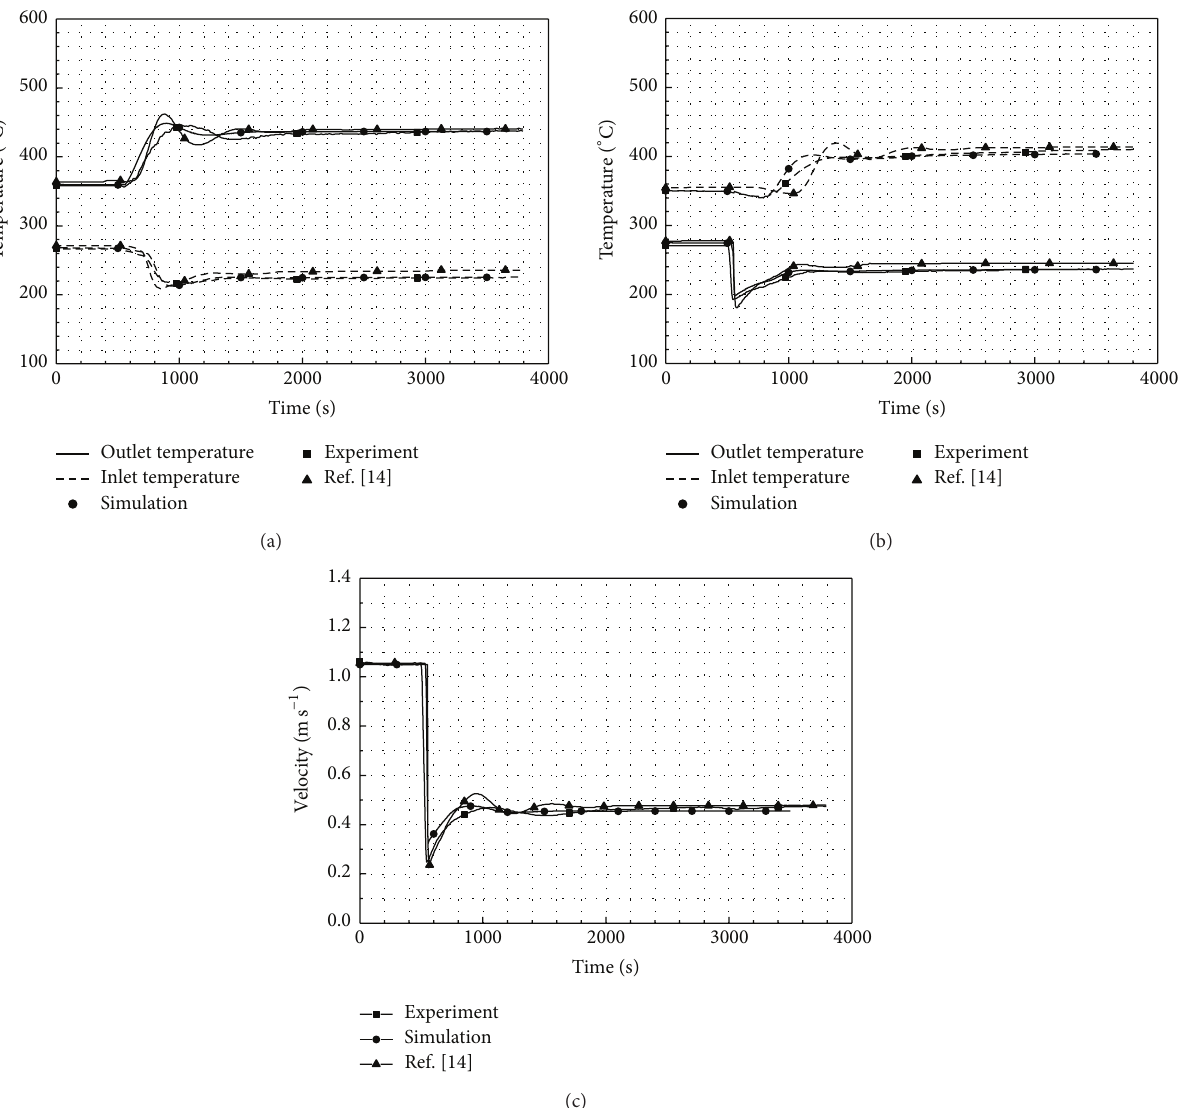
Figure 7: Variation of (a) core tank inlet/outlet temperature, (b) IHX inlet/outlet temperature, and (c) velocity of coolant in